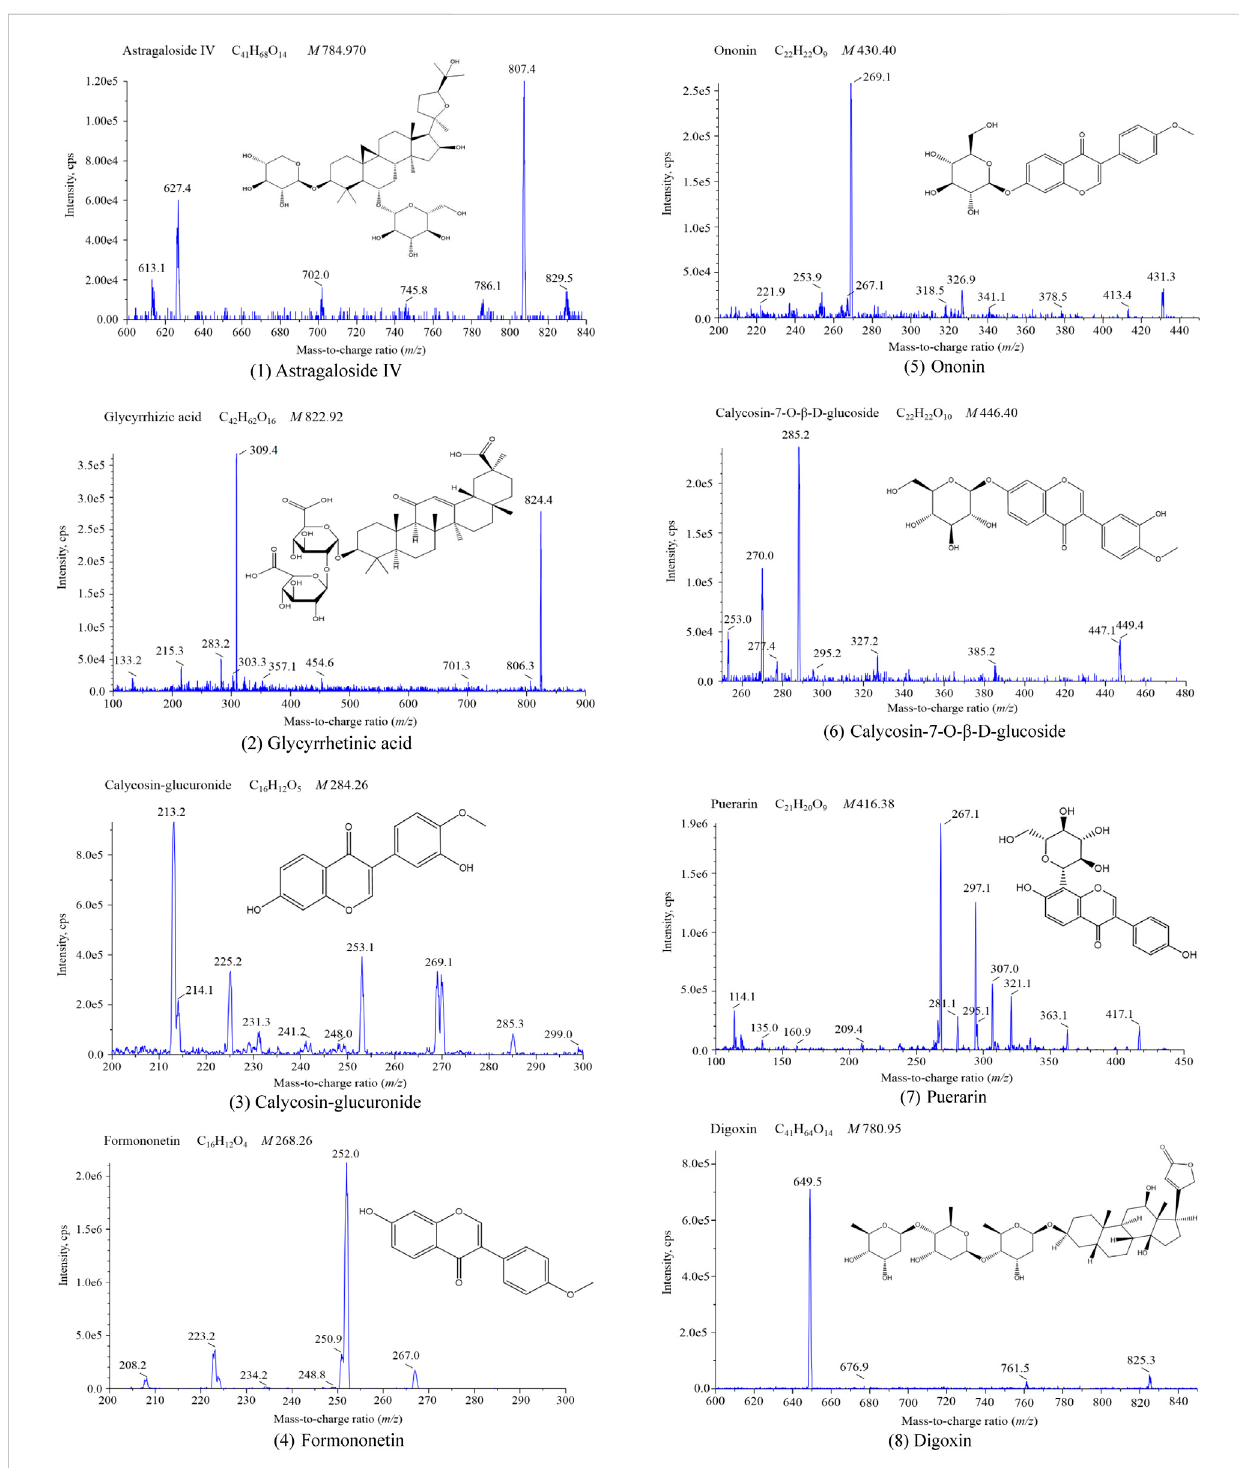
FIGURE 2 Mass spectrogram of the six components and internal standards (1) Astragaloside IV; (2) Glycyrrhetinic acid; (3) Calycosin-glucuronide; (4) Formononetin; (5) Ononin; (6) Calycosin-7-O- β -D-glucoside; (7) Puerarin; (8) Digoxin.